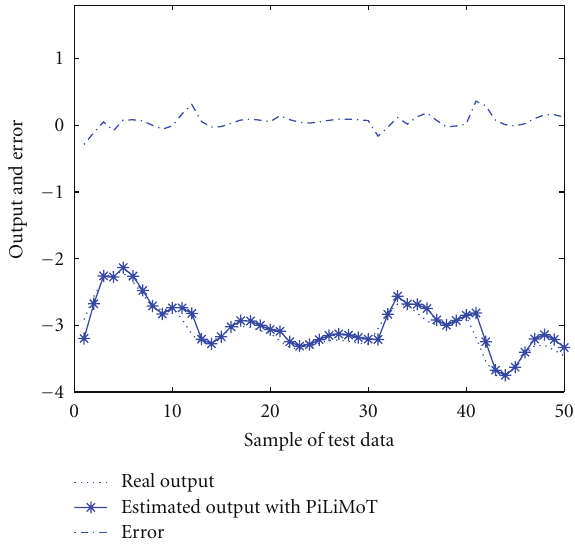
Figure 5: Convergence curves in comparing original LoLiMoT and original PLN with PiLiMoT learning algorithm in testing data.